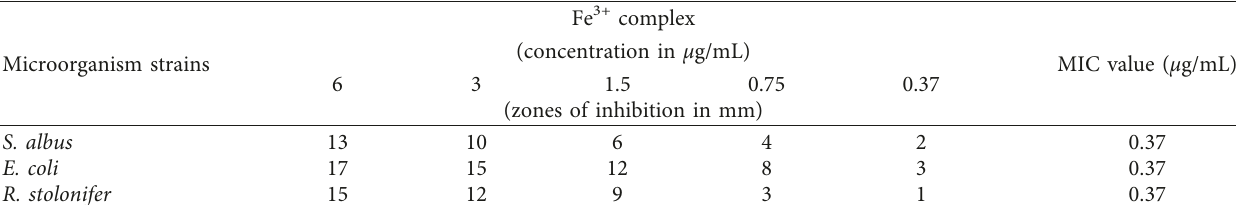
Table 3: Zones of inhibition for antimicrobial activities of the tested Fe 3+ complex of the derivative (L).